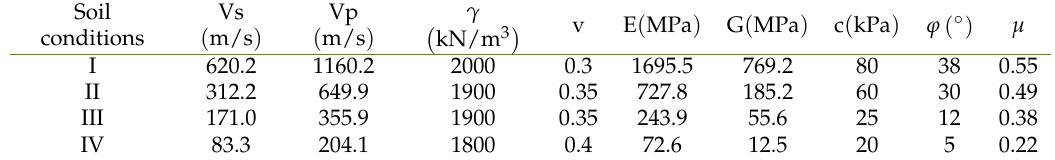
Table 4. Values of 3D visco- elastic artificial boundary